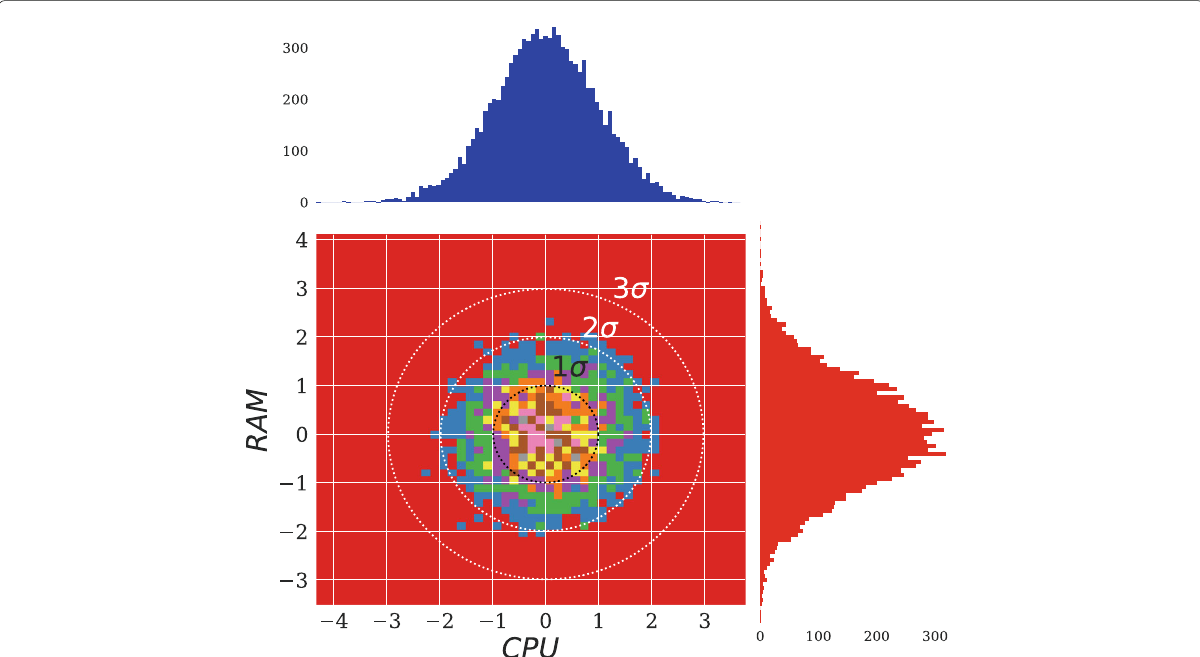
Fig. 1 Illustration of machine scoring in two dimensions (CPU and memory), with machines closer to the targets having a value closer to